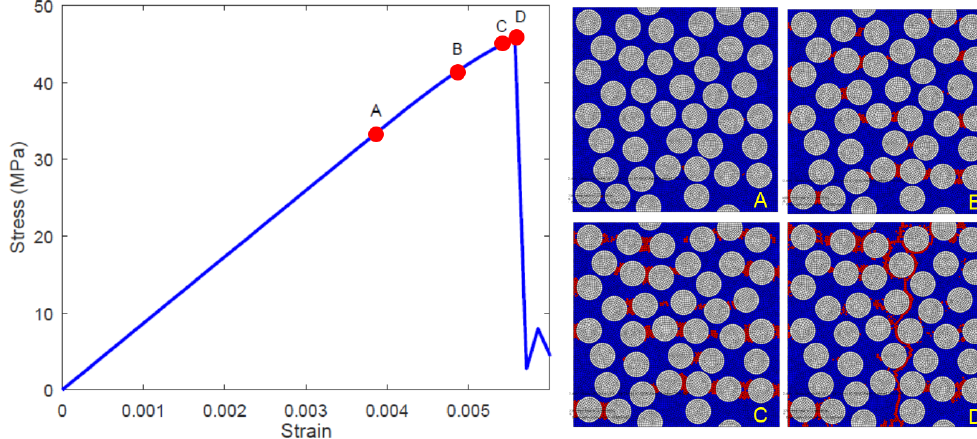
Figure 12. Matrix elements entering crackband in a realization of 40-fiber unit cell (#2) that cause nonlinearity starting at ( A ) through ( B ) and ( C ) but just before the peak at ( D ) ( left ); Complete failure in the matrix elements that is reflected as a sharp vertical crack in the unit cell ( right ) past the peak ( D